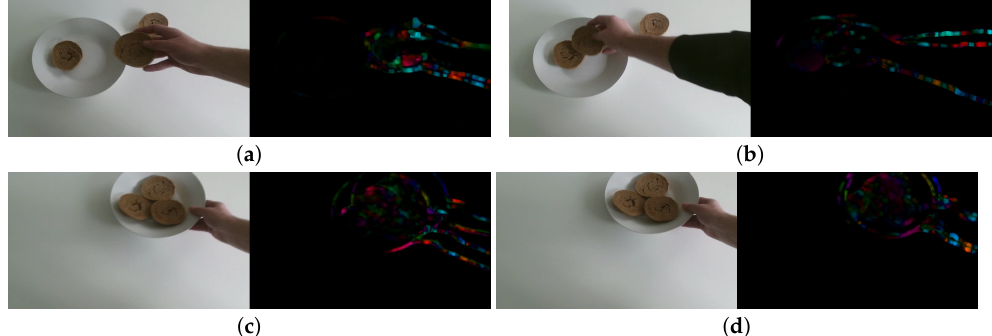
Figure 8. Visualization of Dense Optical Flow with Lucas–Kanade: ( a ) moving ntakos, ( b ) moving ntakos inside the plate, ( c ) moving plate with ntakos, ( d ) moving plate with